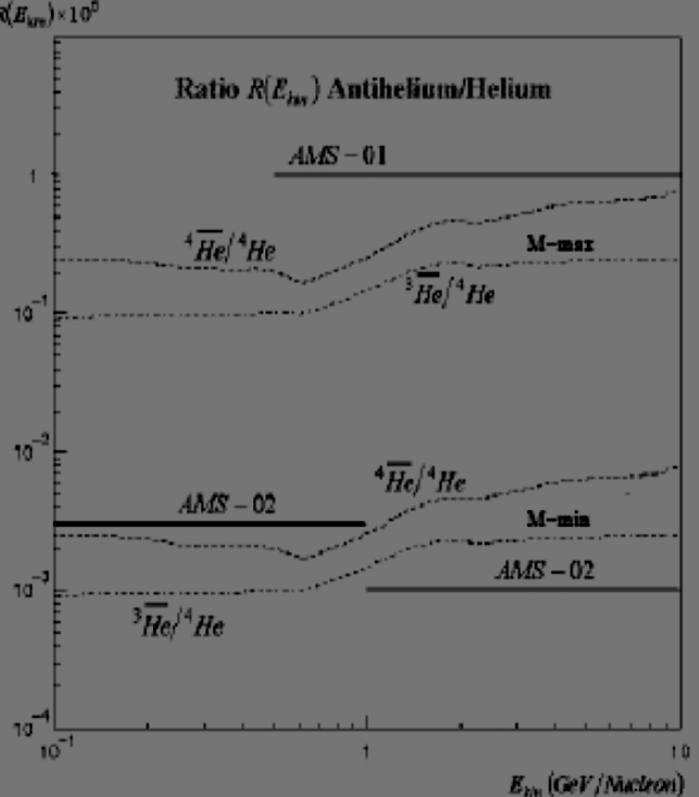
Figure 3. The minimal and maximal estimation of the ratio of fluxes of antiHe-3 and antiHe-4 and the flux of cosmic He nuclei [90] for the minimal and maximal estimation of mass of antimatter globular cluster in comparison with possible sensitivity of AMS01 and AMS02